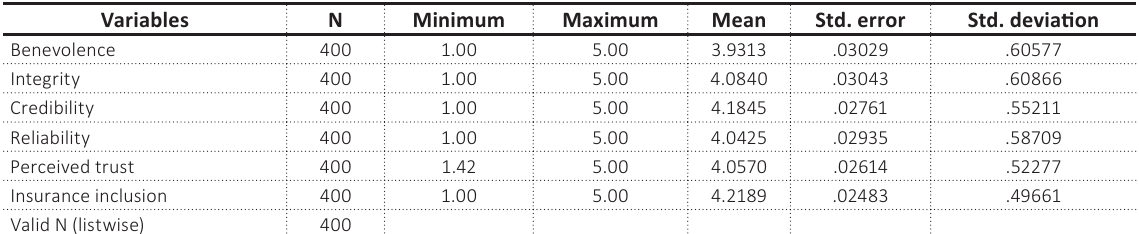
Table 3. Descriptive statistics for study variables